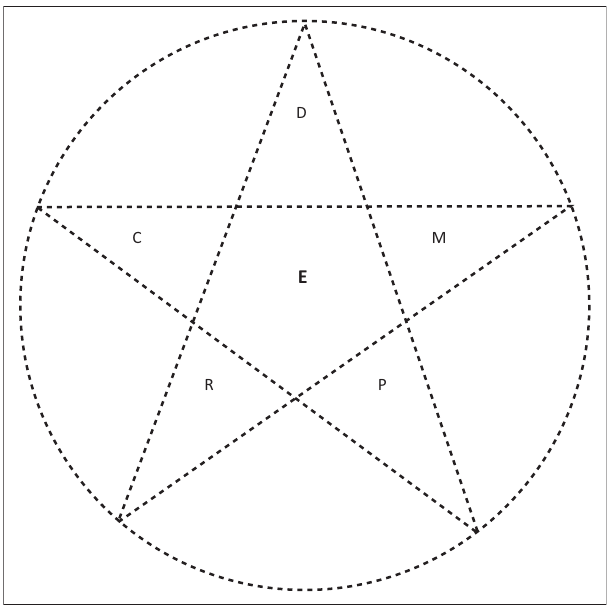
FIGURE 2: Web of potential